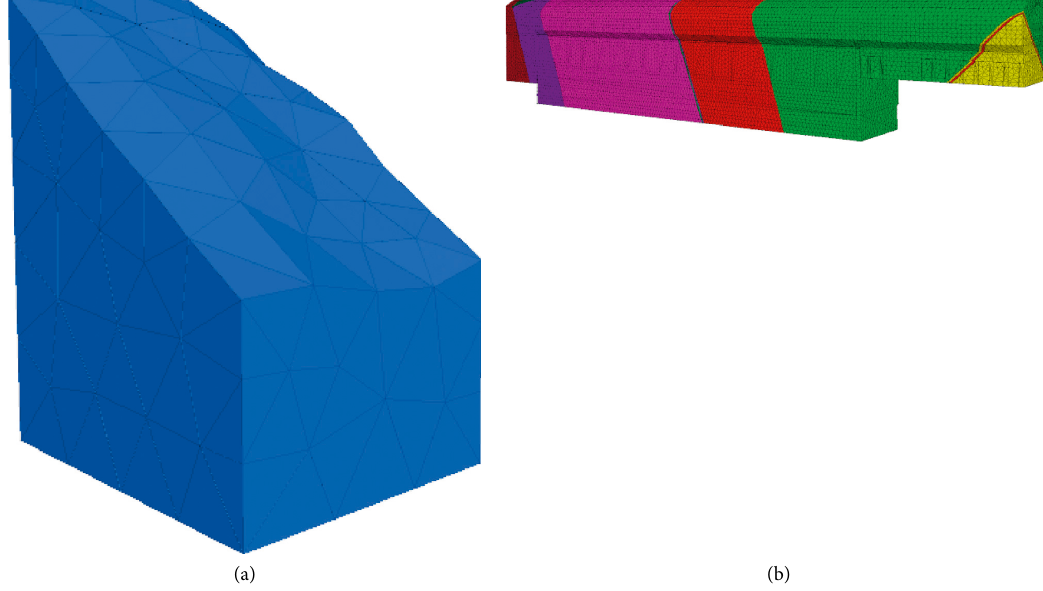
Figure 12: Numerical model established in 3DEC. (a) Mountain model. (b) Plant model.